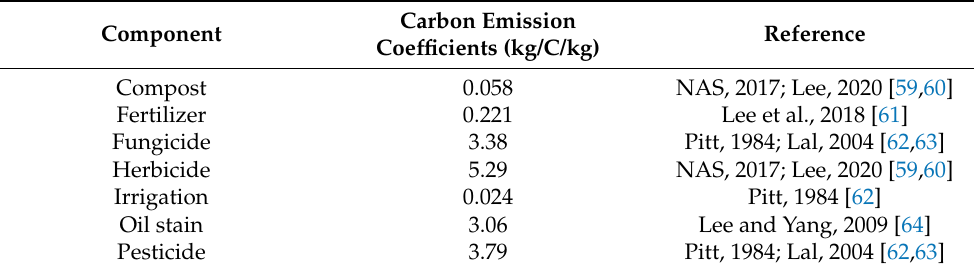
Table 3. Carbon emission coefficients used to estimate the carbon budget of study